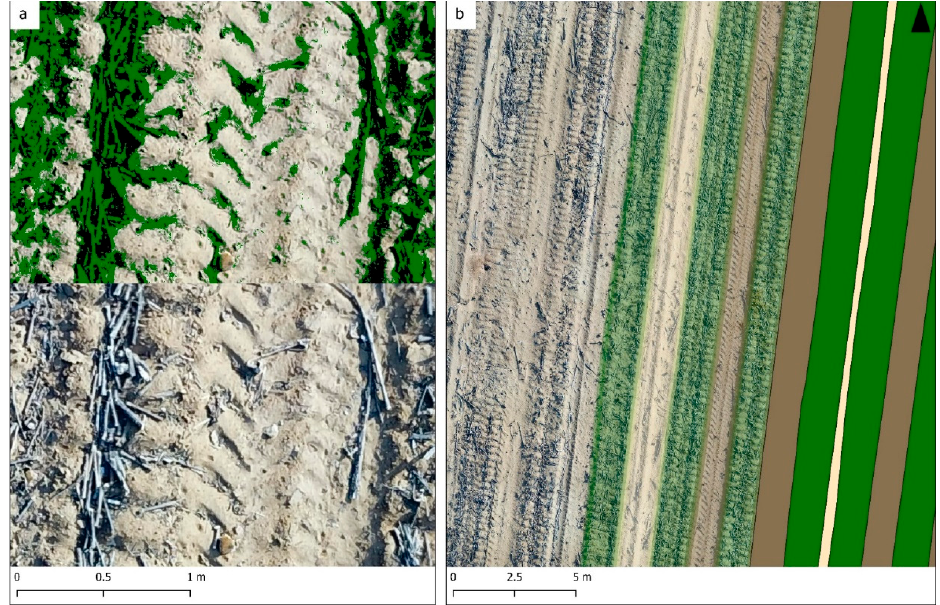
Figure 5. The results of the image analysis on the sunflower field: green represents the identified stubble cover, black represents shadow, and the remaining surface has been identified as soil ( a ). Distribution of the row types in the sunflower fields, where green is used for the planting rows, brown are the track rows, and crust is beige ( b ).